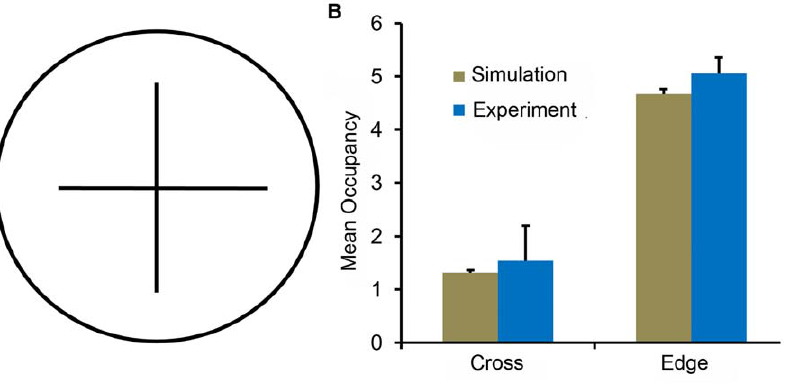
Figure 4. Mean occupancy in different zones of a concentric circular arena. A. An arena was constructed with internal concentric walls. For analysis, the arena was subdivided into 4 zones: zone 1, zone 2, zone 3, and zone 4. B . The behavior of flies was examined in the concentric circle arena. The mean occupancies in four different zones, both from simulations and experiments, are shown. Drosophila showed a preference for the outermost zone. The times spent in these zones by Drosophila were statistically similar to that from the two-component model.